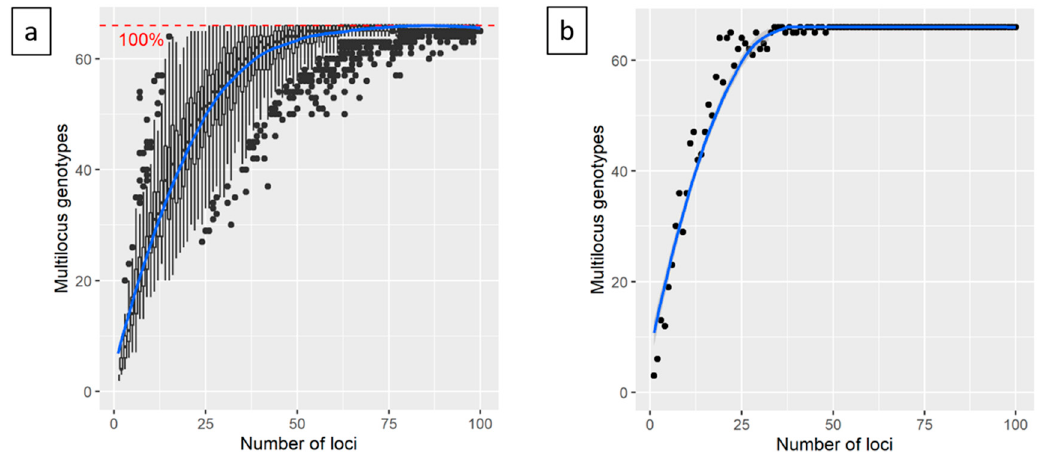
Figure 1. Genotype accumulation curve of 66 grapevine rootstock accessions, genotyped over 14,180 SNP loci, obtained with poppr package ( a ) and AMaCAID package ( b ). Value on Number of loci axis was limited to 100. The red dashed line represents 100% of the total observed genotypes.